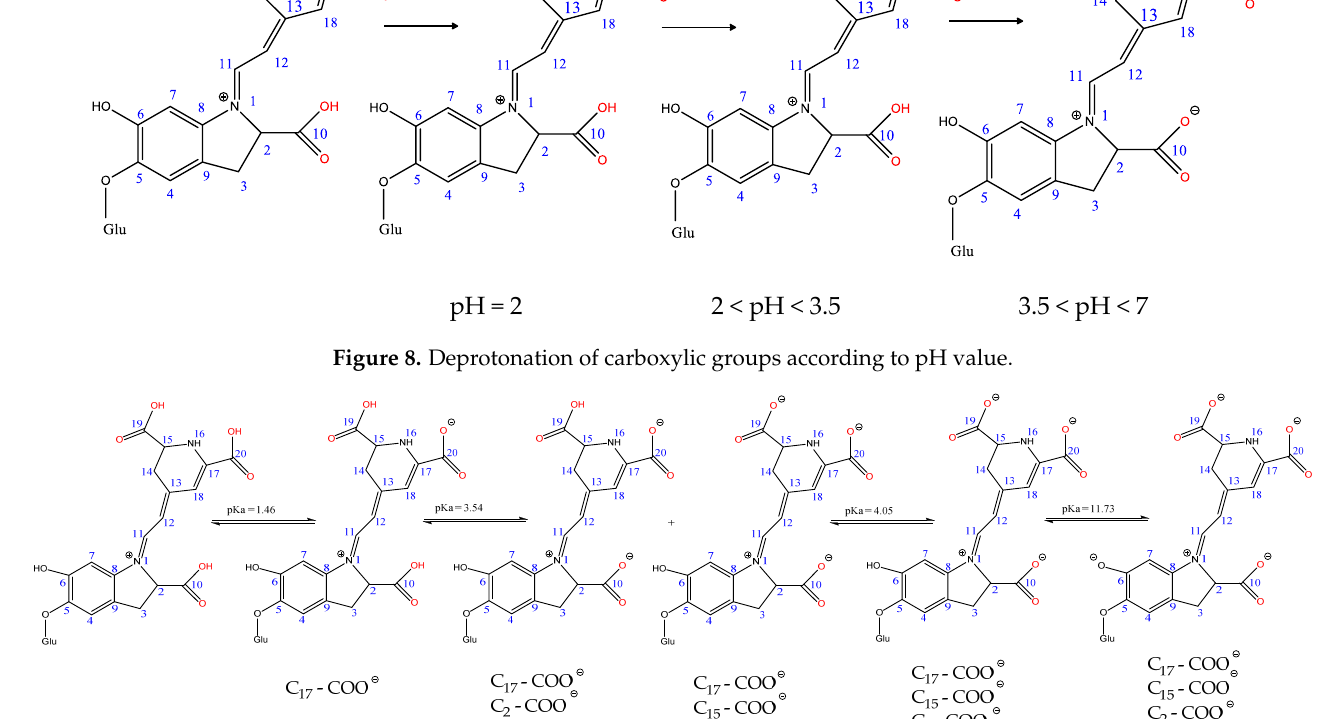
Figure 9. Deprotonation of carboxylic groups in betanin depending on the pKa value.